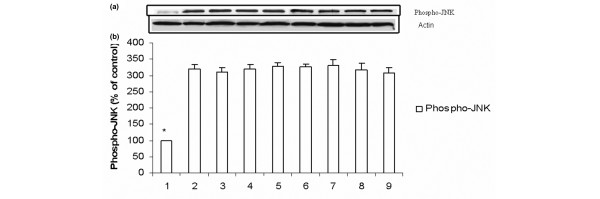
Western blot analyses of of phospho-JNK. (a) Representative Western blot and (b) densitometric analysis of five blots (mean ± standard error of the mean) expressed as a percentage of values for corresponding control-treated tissue samples (no ischemia or reperfusion). Groups: 1 = control, nonischemic group; 2 = ischemia/reperfusion; 3–5 = IB-MECA 50 μg/kg, 100 μg/kg, and 300 μg/kg, respectively, administered before reperfusion; 6 and 7 = MRS3558 50 μg/kg and 100 μg/kg, respectively, administered before reperfusion; 8 = MRS1191 pretreatment before MRS3558 (100 μg/kg) and beginning of reperfusion; and 9 = DMSO administration. Densitometry data presented is normalized to the intensity of actin bands. *P < 0.001 versus the other groups. DMSO, dimethyl sulfoxide; JNK, c-Jun amino-terminal kinase.